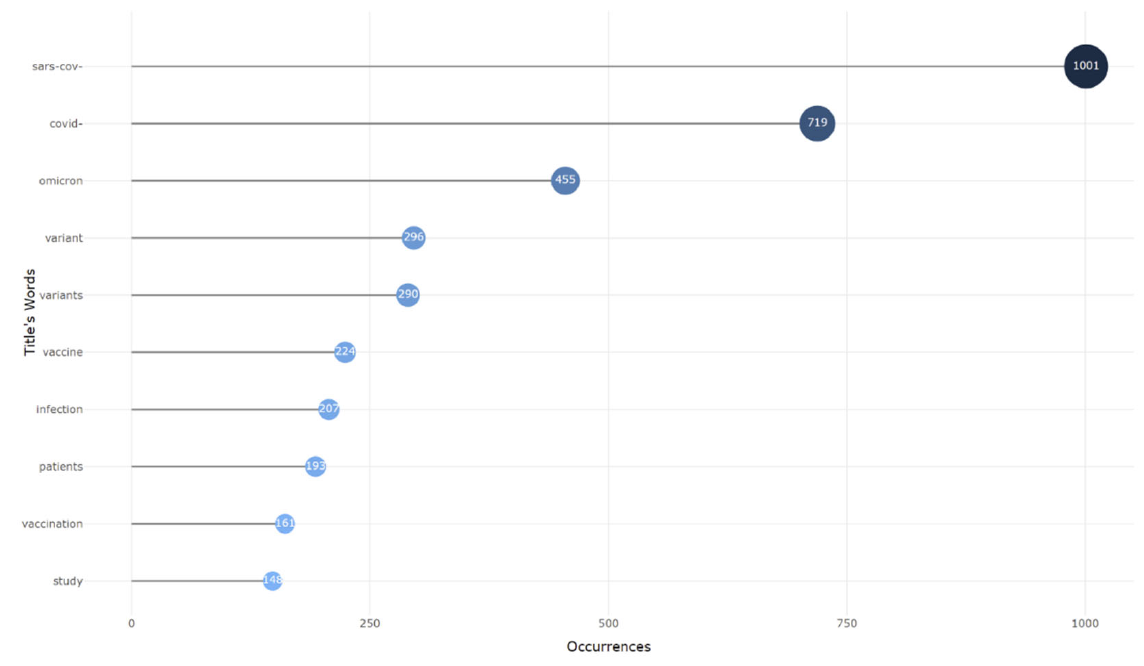
Figure 9. The most relevant words used in Omicron based studies.